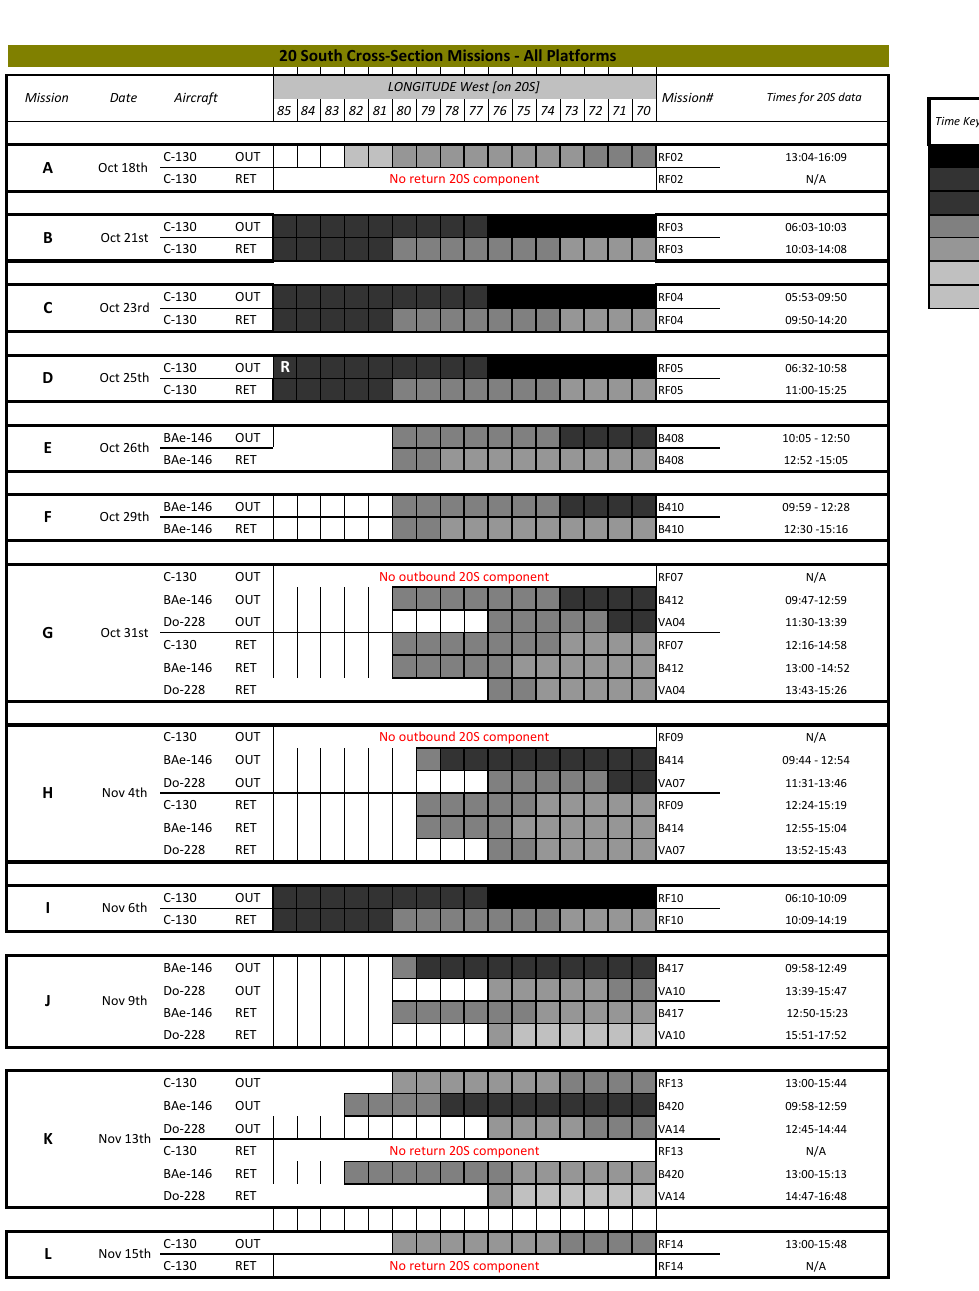
Fig. 6. Cross Section missions summary as a function of date and longitude along 20 ◦ S. Color coding shows the approximate local/UTC time of sampling. Times for which Cross-Section mission data is available are provided at right. Individual aircraft flight numbers are also given. Missions with missing outbound or return legs indicate that the aircraft was involved in a different mission for part of its flight. 1. Cross-Section (XS) missions along 20 ◦ S latitude